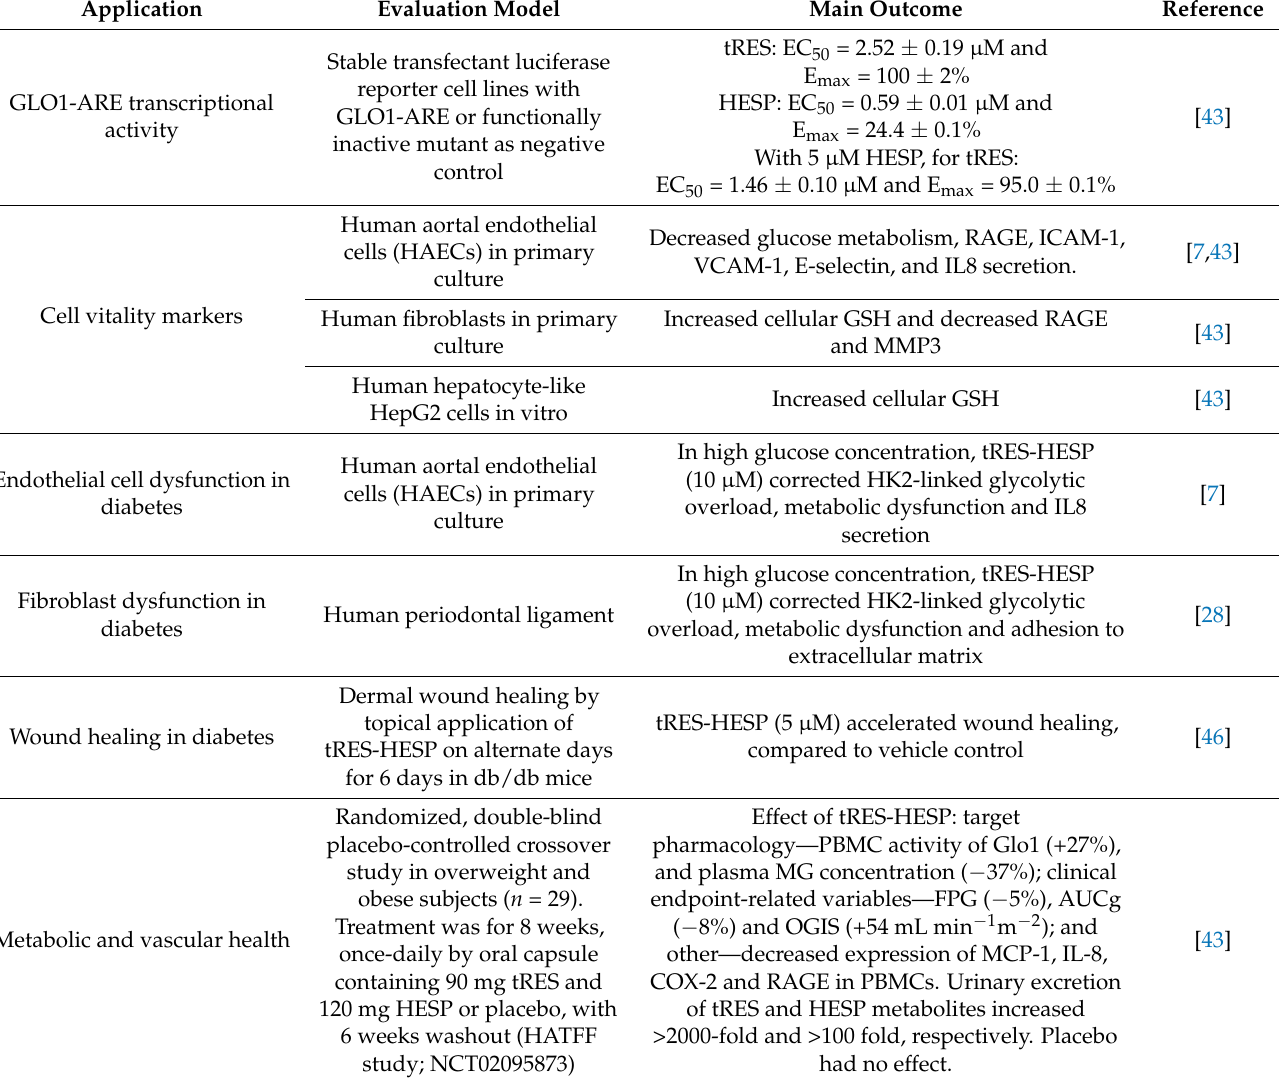
Table 1. Pharmacological activity of glyoxalase 1 inducer, trans -resveratrol and hesperetin, in pre- clinical disease models and clinical